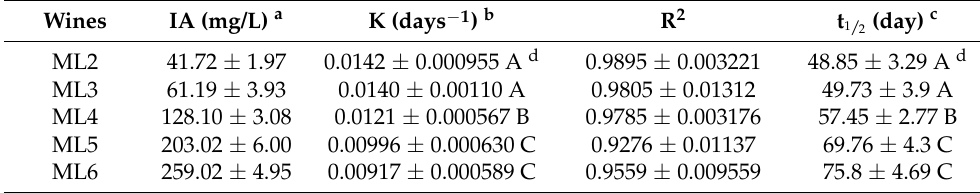
Table 1. Kinetic parameters of the loss of acetaldehyde in Merlot wines during aging reaction. Wines IA (mg/L) a K (days − 1 )